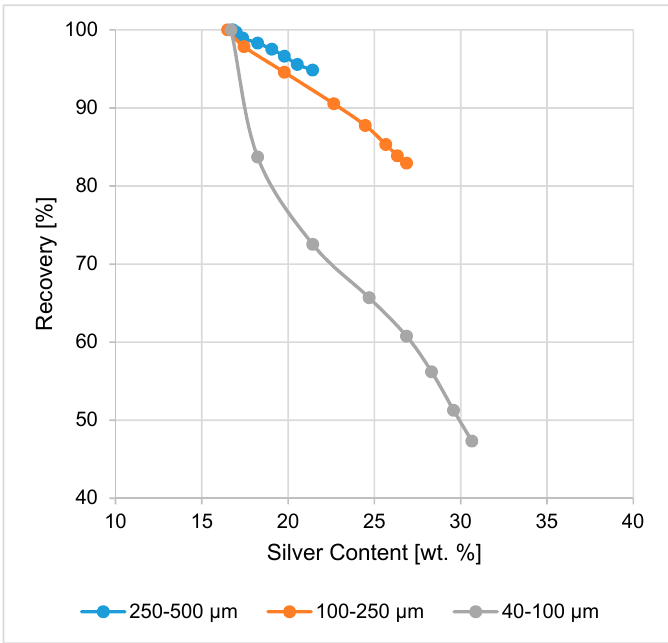
Figure 6. Cumulative silver recovery (%) and Ag-content (wt. %) in product using magnetic separation.